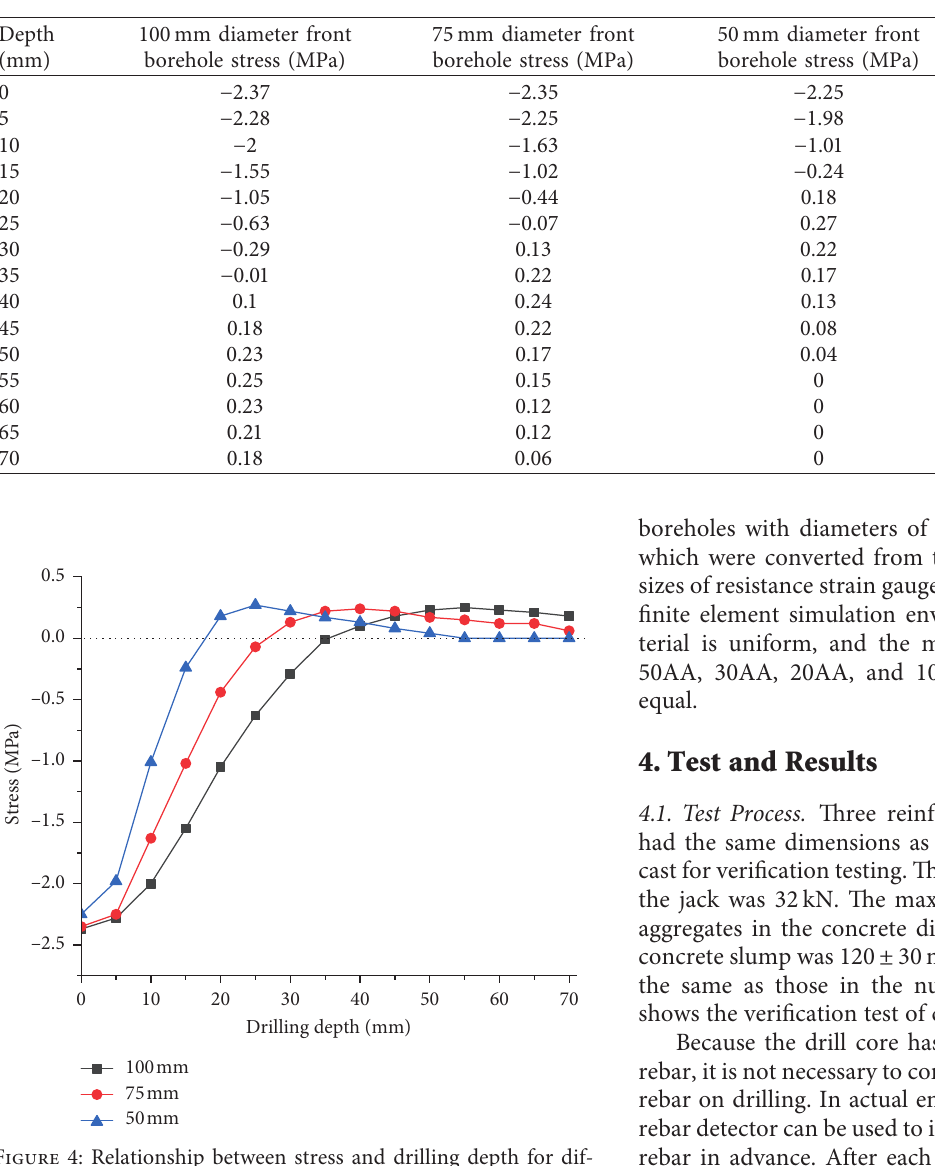
Table 1: Stress data from boreholes of various